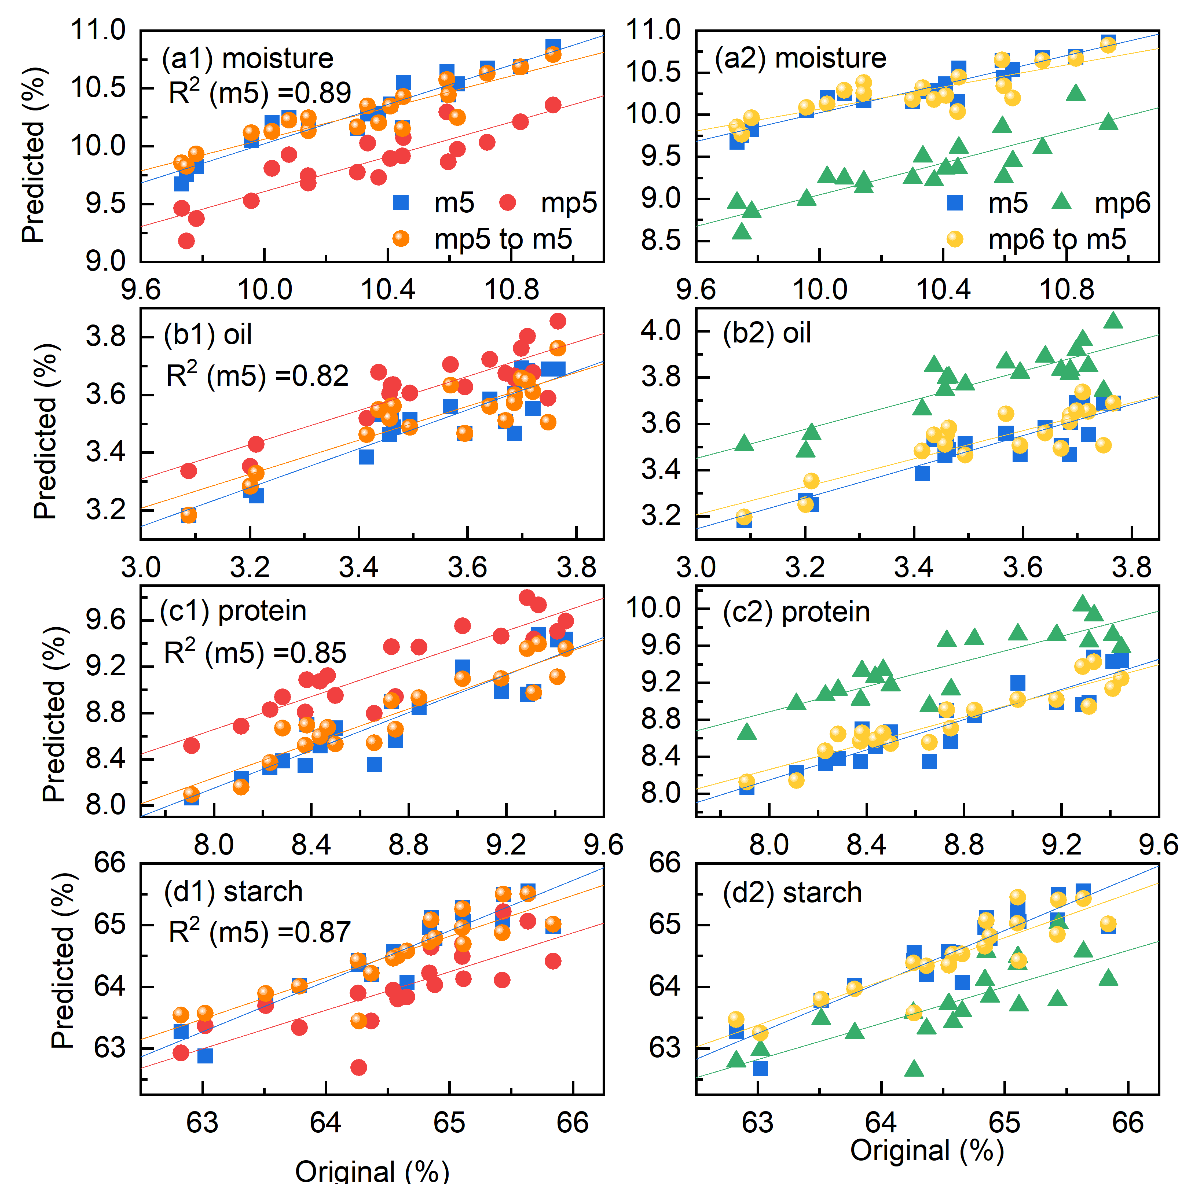
Figure 7. Relationship between the original and the prediction values of moisture ( a ), oil ( b ), protein ( c ), and starch ( d ) obtained from the spectra from m5, mp5, and mp6, as well as the transferred spectra of mp5–m5 and mp6–m5, respectively.